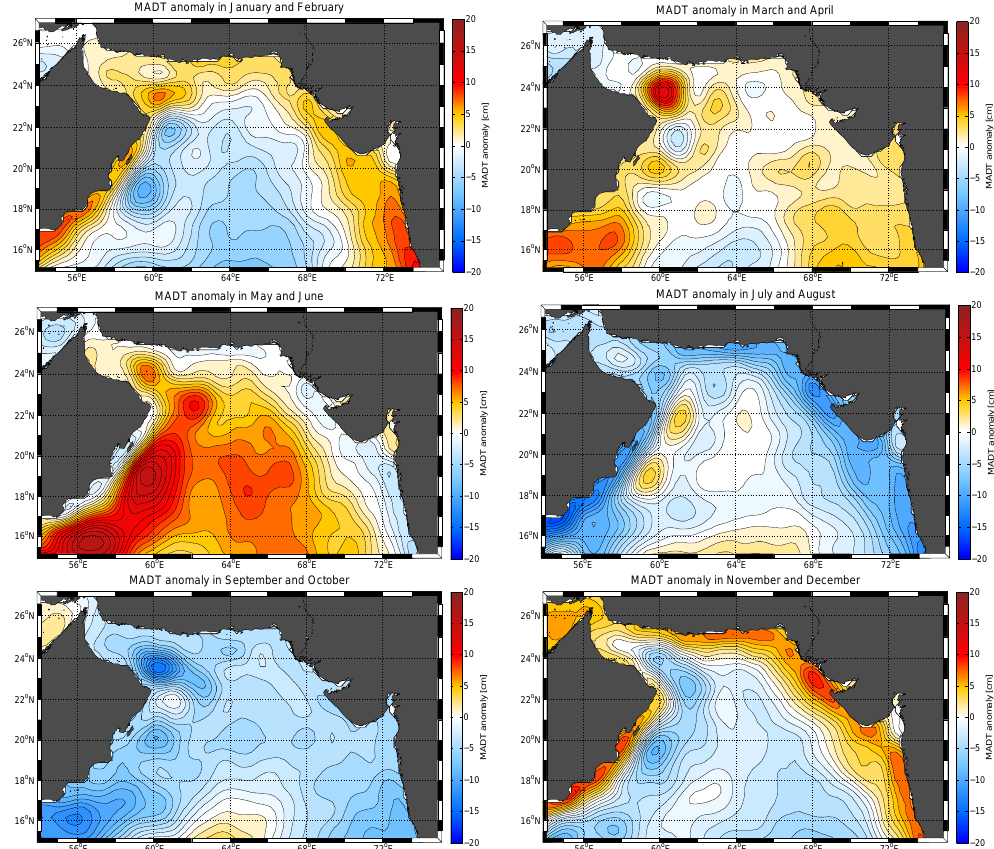
Figure 2. Bi-monthly averaged MADT anomaly (see data and method section for computation) using AVISO data, over years 1992 to 2014. Positive values of the anomaly correspond to an anticyclonic motion, whereas negative ones correspond to a cyclonic motion. Top: January and February (left), March and April (right); center: May and June (left), July and August (right); bottom: September and October (left), November and December